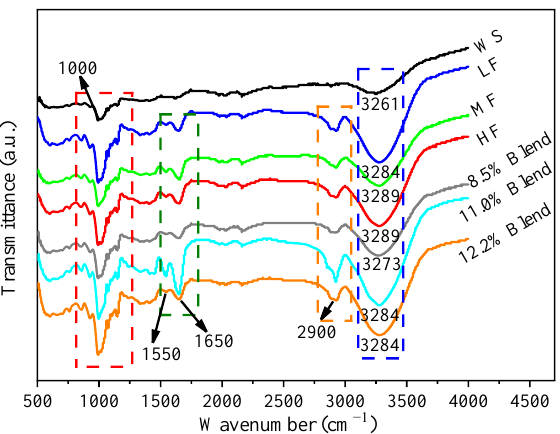
Figure 10. FTIR spectra for the films of pure WS, wheat flours, and WS–gluten blends with different protein contents (8.5%, 11.0%, and 12.2%).